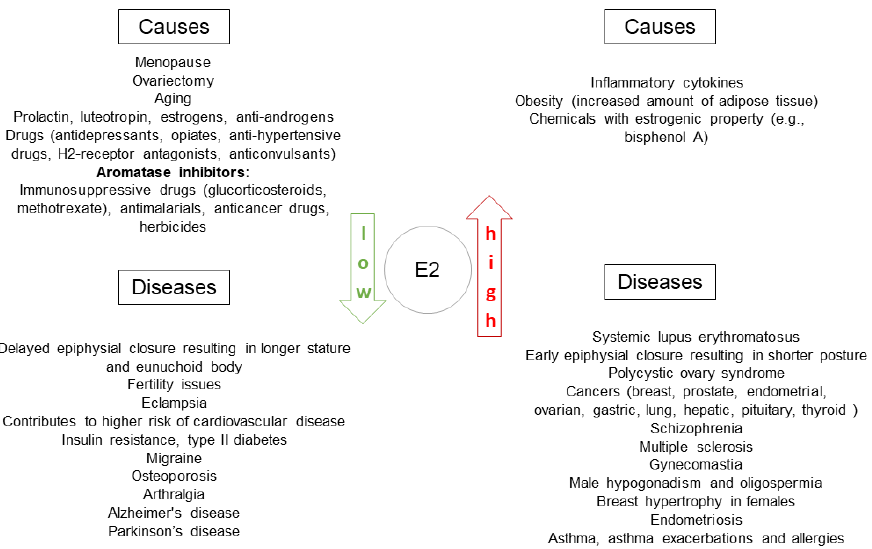
Figure 2. Diseases related to estrogen balance with observed prevalence among women. E2: estra-